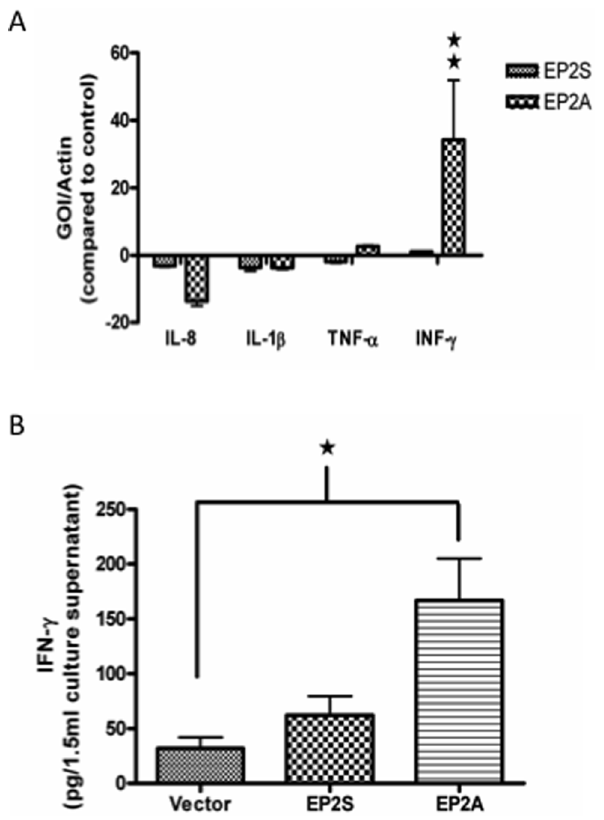
Figure 6. EP2A cells over express IFN- c . (A) The expression of transcript for cytokines (IL-8, IL-1 b , TNF- a and IFN- c ) in Caco-2 EP2S and EP2A cells was measured by Q-PCR. The gene of interest (GOI) was normalized with the internal control (Actin) and depicted as fold changes with that of vector control. IFN- c expression in EP2A cells was statistically compared with that of vector control. (B) Cell culture supernatant collected from Caco-2 cells (vector control, EP2S and EP2A) were quantified for IFN- c using eBioscience’s Human IFN- c ELISA Kit. w p , 0.05; ww p , 0.01.